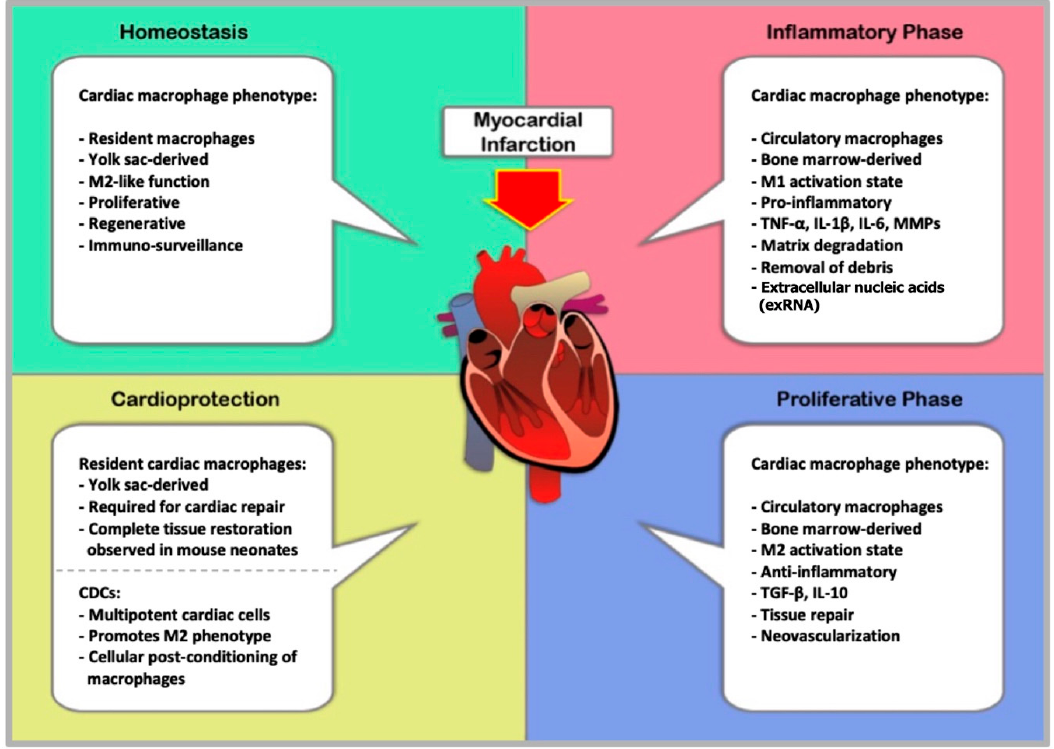
Figure 1. The Cardiac macrophage population, while the heart is in homeostasis, consists primarily of yolk sac-derived macrophages. However, these resident tissue macrophages diminish in number with age and are replaced by circulating bone marrow-derived monocytes even in the absence of inflammation. BMDM replenish the cardiac macrophage supply, and exhibit M2 activation in the steady-state heart. The inflammatory phase of acute myocardial infarction initiates an immune response by monocytes/macrophages, which are recruited to the injured tissue. Ly6CHigh monocytes infiltrate and accumulate in the injured area where they differentiate into “classical” M1 macrophages. M1 macrophages secrete pro-inflammatory cytokines and MMPs upon activation by DAMPs. The inflammatory response peaks at around day 5–7 and ultimately results in clearance of dead cells and cell debris, processes essential for tissue repair. Resolution of inflammation after MI marks the beginning of a proliferative phase. During which, circulating Ly6CLow monocytes infiltrate the infarcted area. Thus, the population of cardiac macrophages begins to move toward alternative activation. The presence of M2 macrophages suppresses inflammation, enhances tissue repair and promotes angiogenesis by the expression of TGF- β and IL-10. Dysregulation of either the inflammatory or proliferative phase can produce severe outcomes like ventricular weakening, fibrosis, and compromised function. Macrophages can participate in cardioprotection via cell-mediated mechanisms. For example, yolk sac-derived cardiac macrophages are required for reparative mechanisms of wound healing. Further, the identical phenotype in murine neonates has full regenerative capacity after MI and remains through adulthood although it diminishes greatly over time and post-MI. CDCs are another example of cellular cardioprotection. The cardiac type of mesenchymal stem cell, CDCs have the potential to induce M2 activation in macrophages. Post-conditioning of macrophages with CDCs results in an alternatively activated phenotype, which has been shown to improve prognosis following myocardial infarction. Abbreviations: BMDM; bone marrow derived macrophages, DAMP; damage associated molecular pattern, MMP; metallo-matrix proteinase; IL-10; interleukin-10, TGF- β ; transforming growth factor- β , CDC; cardiosphere-derived cells.